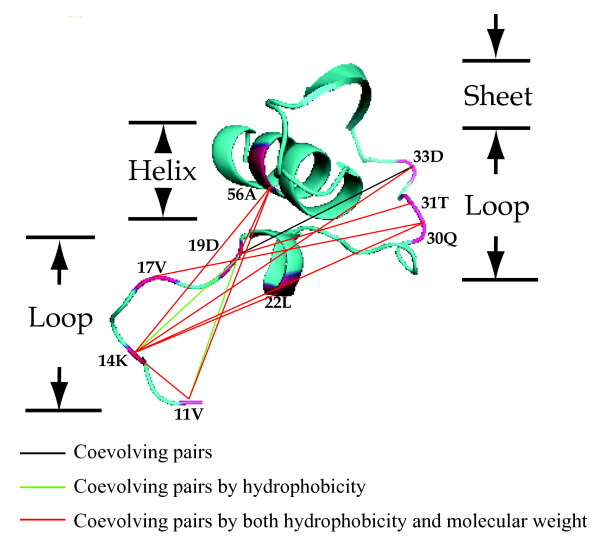
Coevolving sites within the N-terminal structure of the RbcL subunit. Amino acid residues involving in the coevolutionary network are highlighted red in the 3D structural diagram. And the residues are connected differently according to the nature and characteristics of their coevolution.